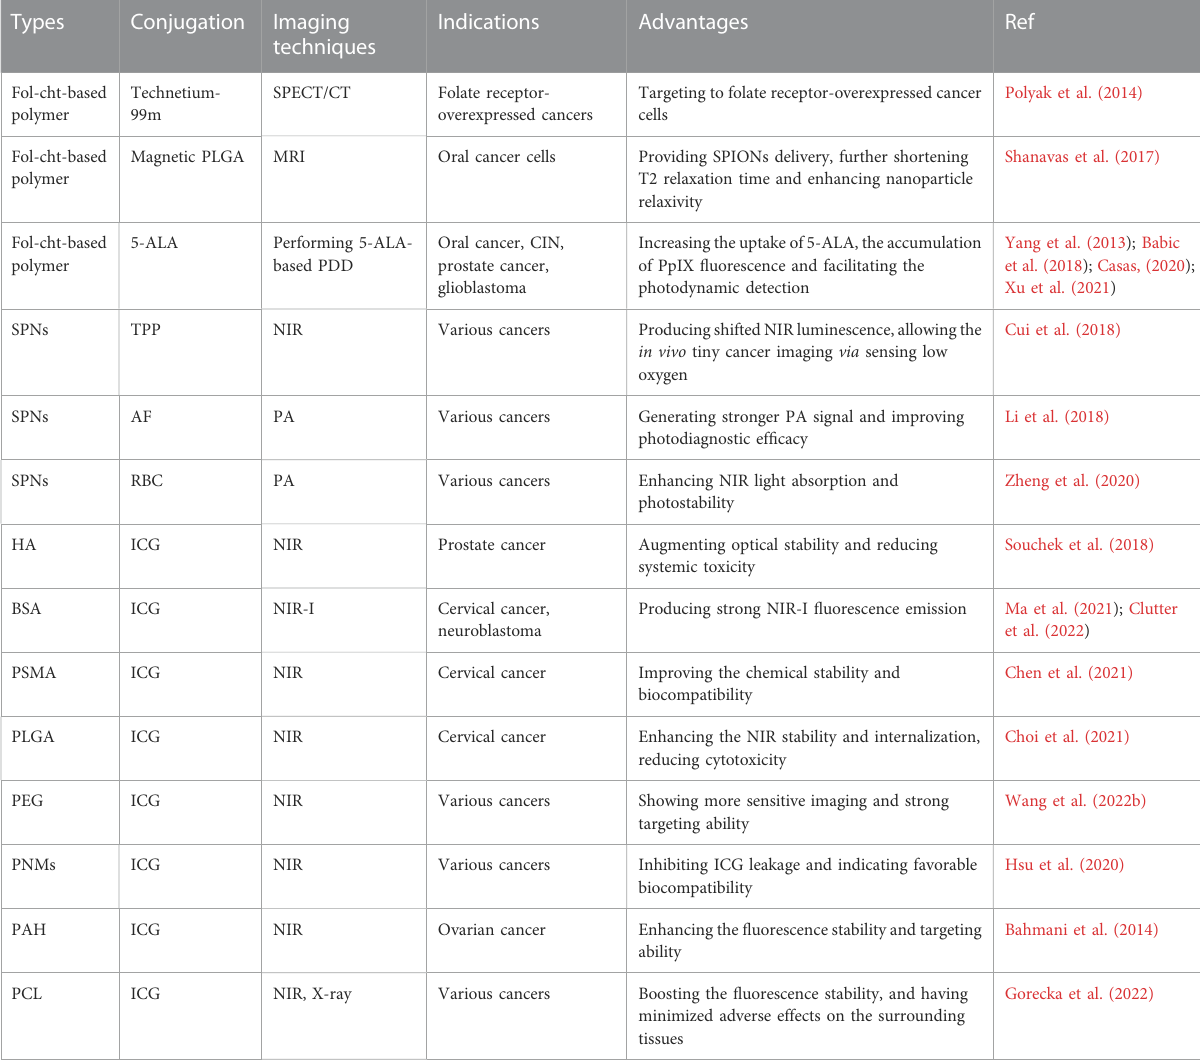
TABLE 1 The applications of novel polymeric nanoagents in cancer